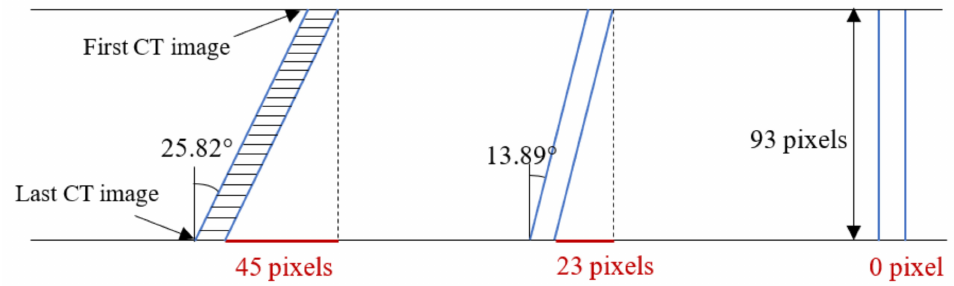
Figure 8. Moving distances of the microchannel to form different inclination